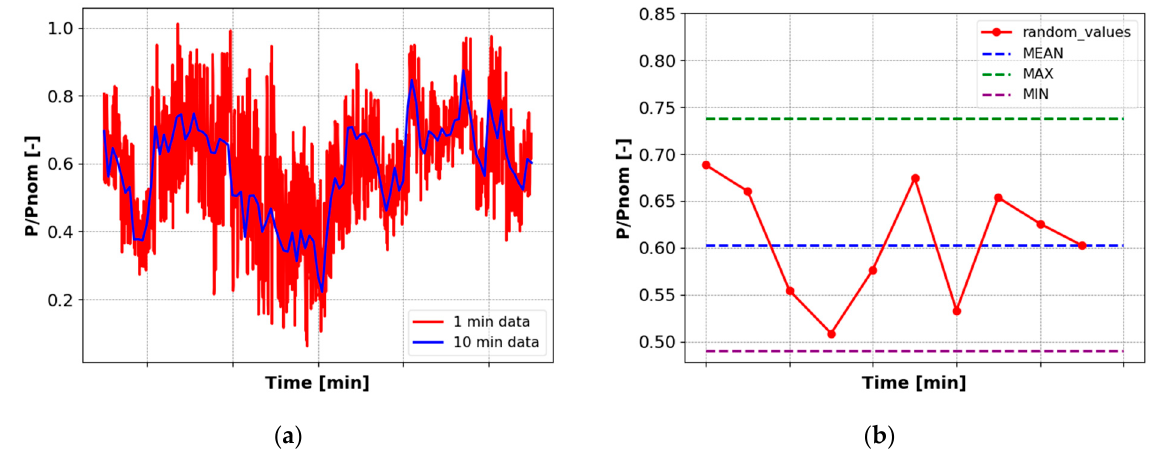
Figure 3. Temporal downscaling of the wind power data: ( a ) power profile modification (10 min vs. 1 min); ( b ) Random values extraction for a bin of 10 min.